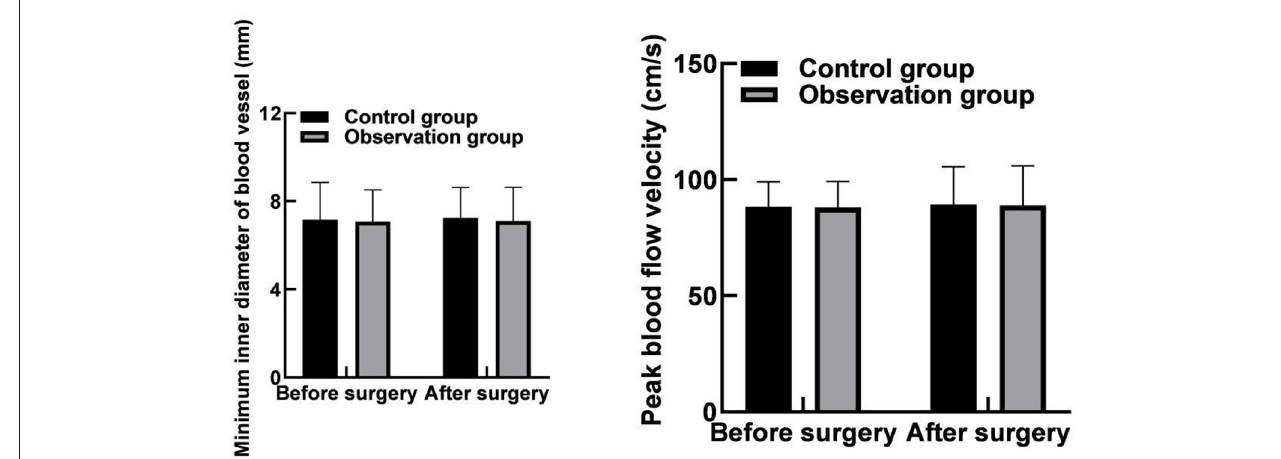
FIGURE 2 | Comparison of vascular parameters at the puncture site between the two groups.